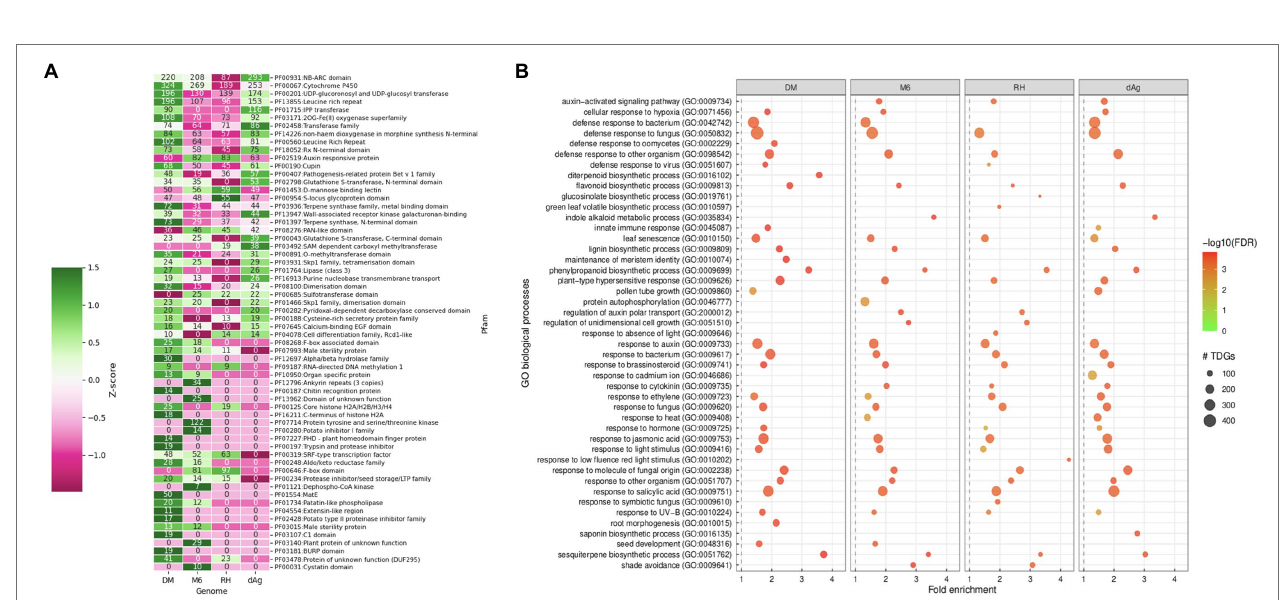
FIGURE 3 | (A–C) Distribution of K a , K s , and K a / K s for tandemly duplicated genes in DM, M6, RH, and dAg, and sorted into bins of width = 0.1. (D–F) Evolutionary patterns of tandemly duplicated genes in DM, M6, RH, and dAg.